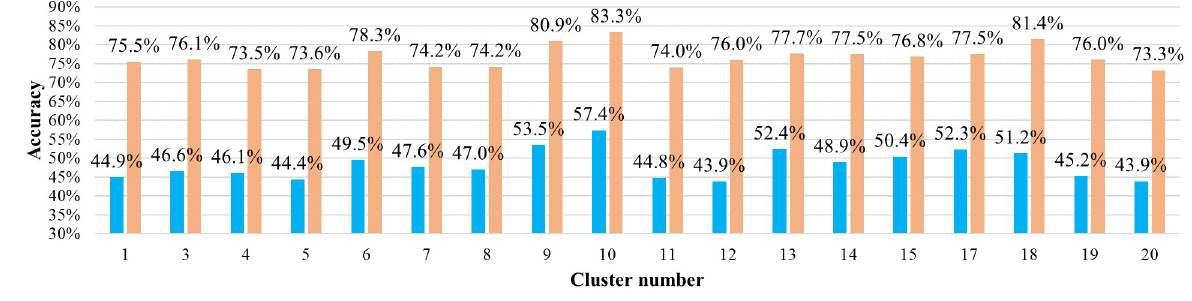
Fig 10. Estimation accuracies by cluster (blue: Normal rule, orange: Relaxed rule). Note: The normal rule indicates the estimated and actual alighting stops are the same, and the relaxed rule indicates the estimated alighting stop is within one stop difference (including previous and next stop) from the actual alighting stop.